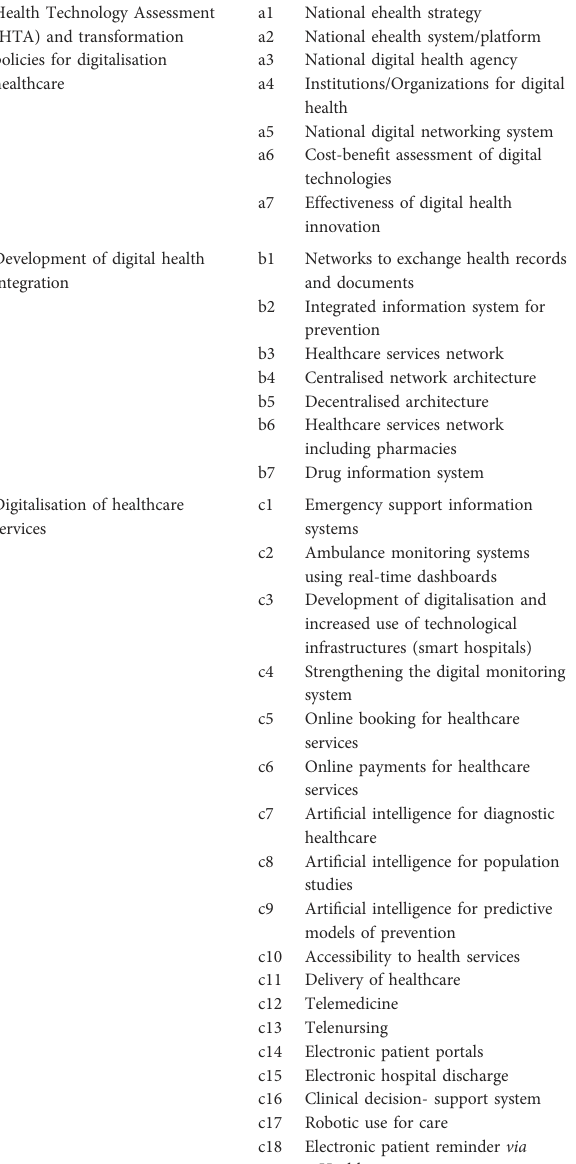
TABLE 1 Topics, identi fi cation codes,